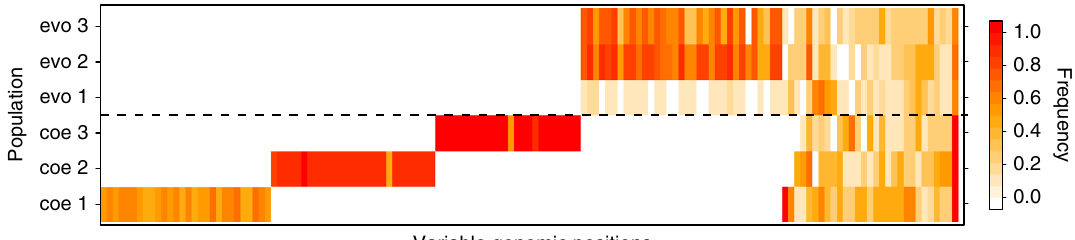
Fig. 4 Frequency and distribution of high frequency variants across replicated populations for 143 variable genomic positions. Only high frequency variants (variants that evolved de novo, reached a frequency of 50% in at least one population, and the position had suf fi cient coverage in 6 out of 10 clones; see Results and Methods sections for more details) are plotted, with their corresponding frequency in the other populations. Each column represents a particular variable genomic position and positions were ordered to best visualize population speci fi c and shared variants across populations. White color indicates no single clone out of 10 of this population had a variant at this position, yellow to red colors indicate increasing frequencies of the variant in that population. Total number of variants = 143. Abbreviations coe1 – coe3 correspond to the three coevolved populations. Abbreviations evo1 – evo3 correspond to the three